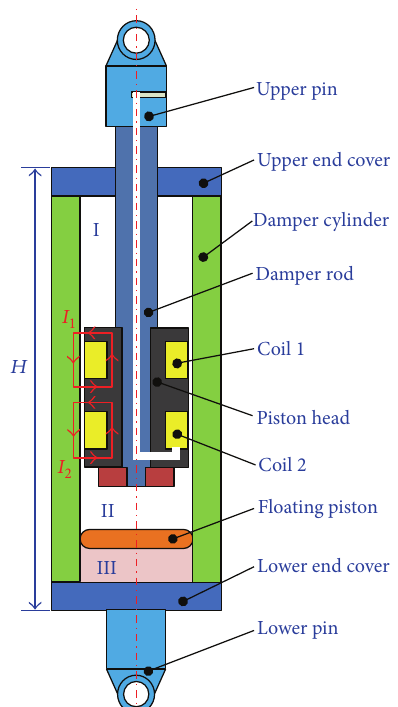
Figure 1: Schematic configuration of the double coil MR damper with annular